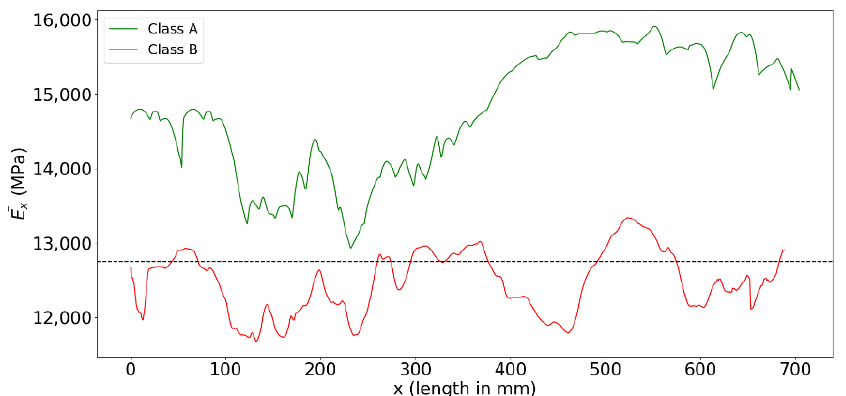
Figure 5. Example of sorting by the stiffness profile principle, with the dashed line being the sorting threshold.